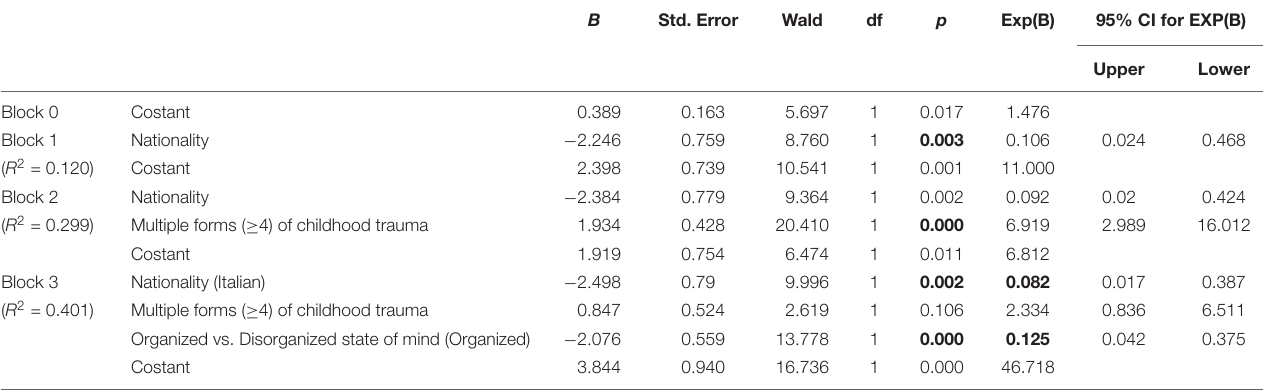
TABLE 10 | Stepwise logistic regression. Variables in the equation.